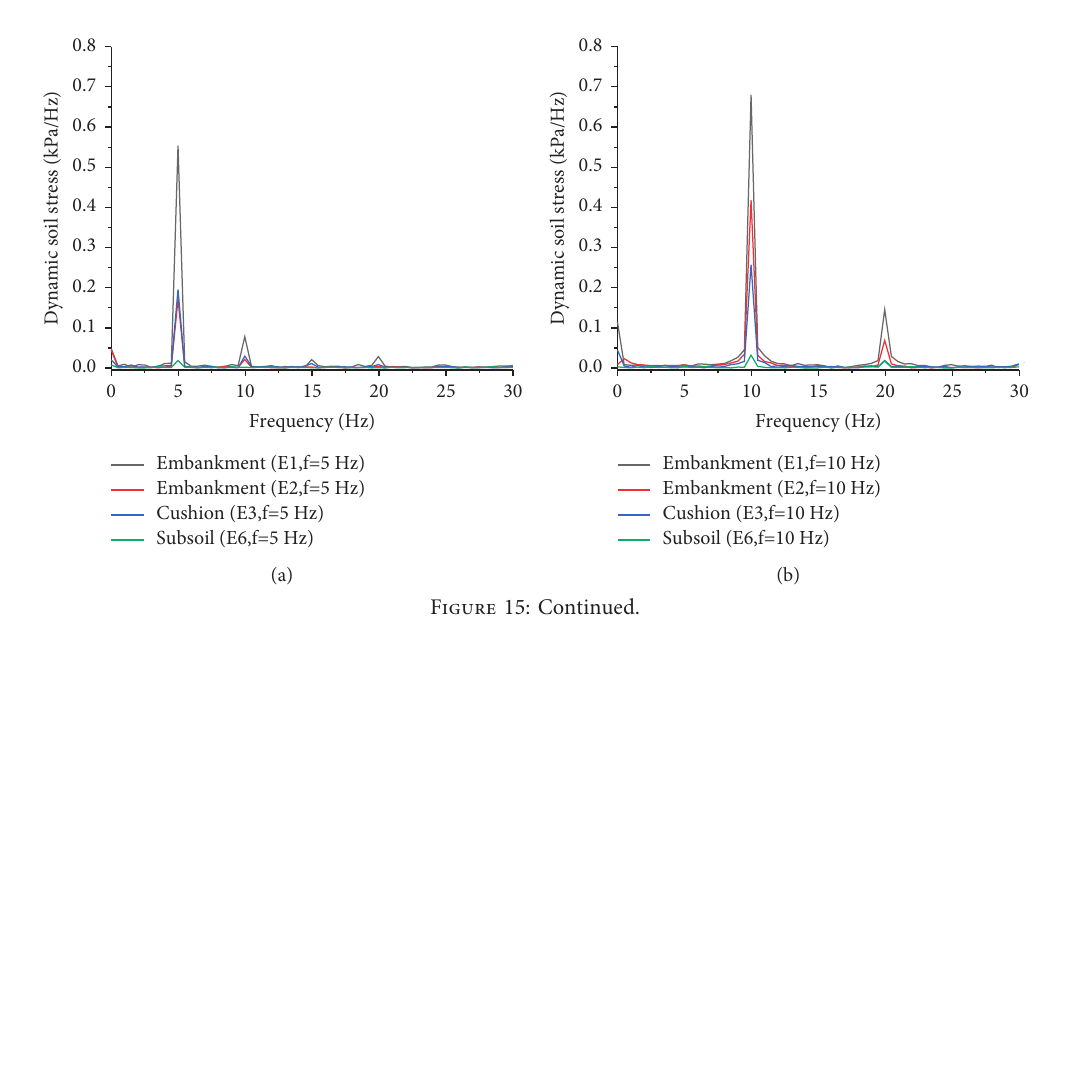
Figure 14: Time history analysis of dynamic soil stress at embankment, cushion, and subsoil for three cyclic loading frequencies. (a) f � 5Hz. (b) f � 10Hz. (c) f �